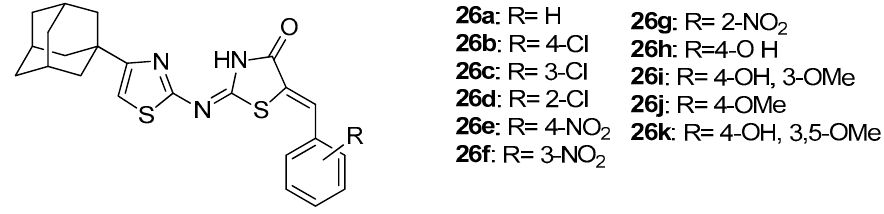
Figure 28. Chemical structures of 4-adamantanyl-2-thiazolylimino-5-arylidene-4-thiazolidinones.